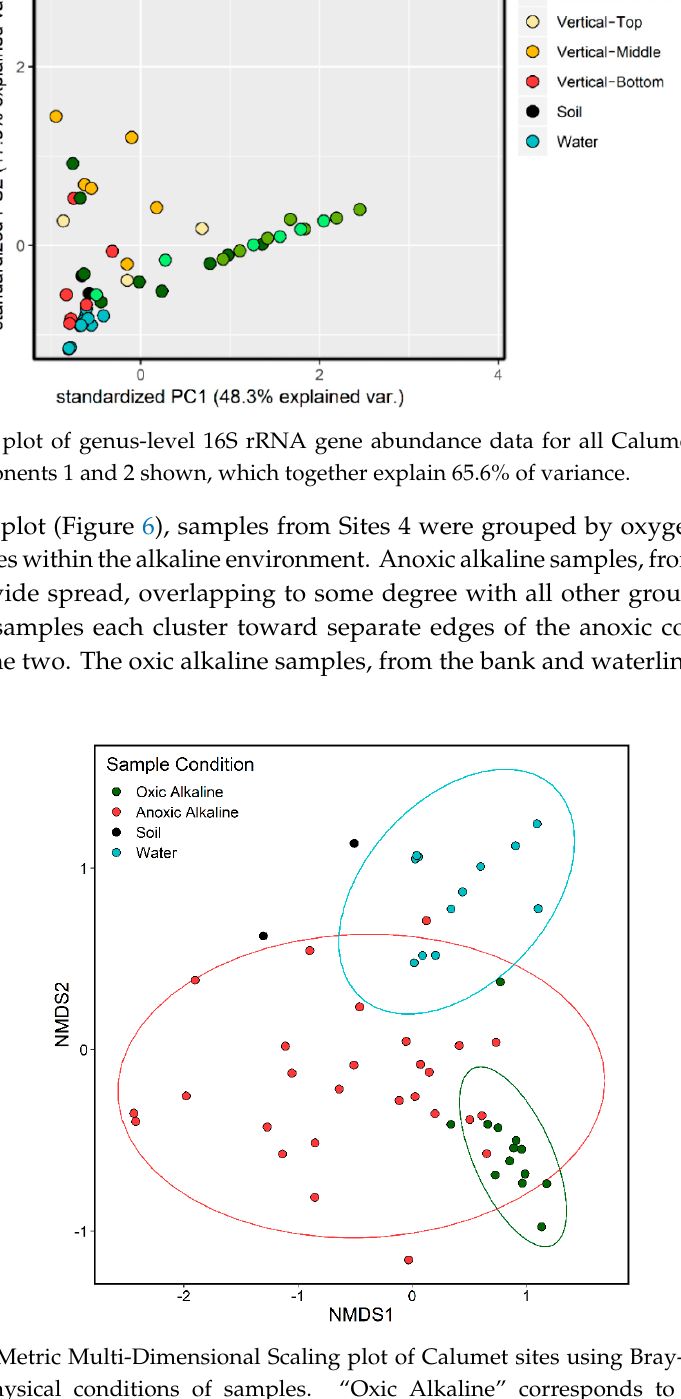
Figure 4. Phylum- and Proteobacterial class-level 16S rRNA gene relative abundances in two vertical transects collected at Site 4: ( A ) 3 cm diameter core collected in April 2014; ( B ) 7.5 cm diameter core collected in March 2015. Depth indicates the top side of each core segment, starting at the top of the calcium carbonate flocculent. Water column is not included, but averaged 5-10 cm above sediment.